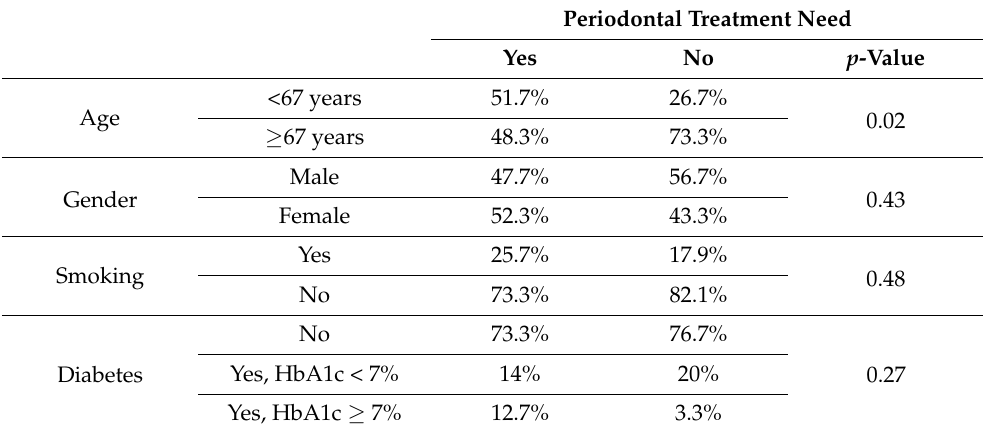
Table 6. Associations between demographic data and periodontal treatment need.